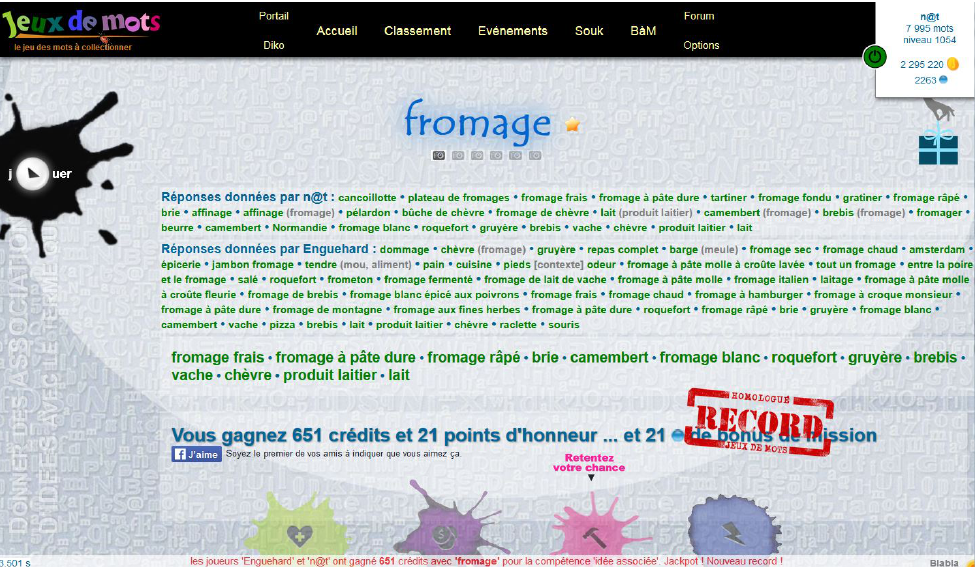
Figure 2: Screenshot of the game result with the target noun fromage . Proposals of both players are displayed, along with points won by both